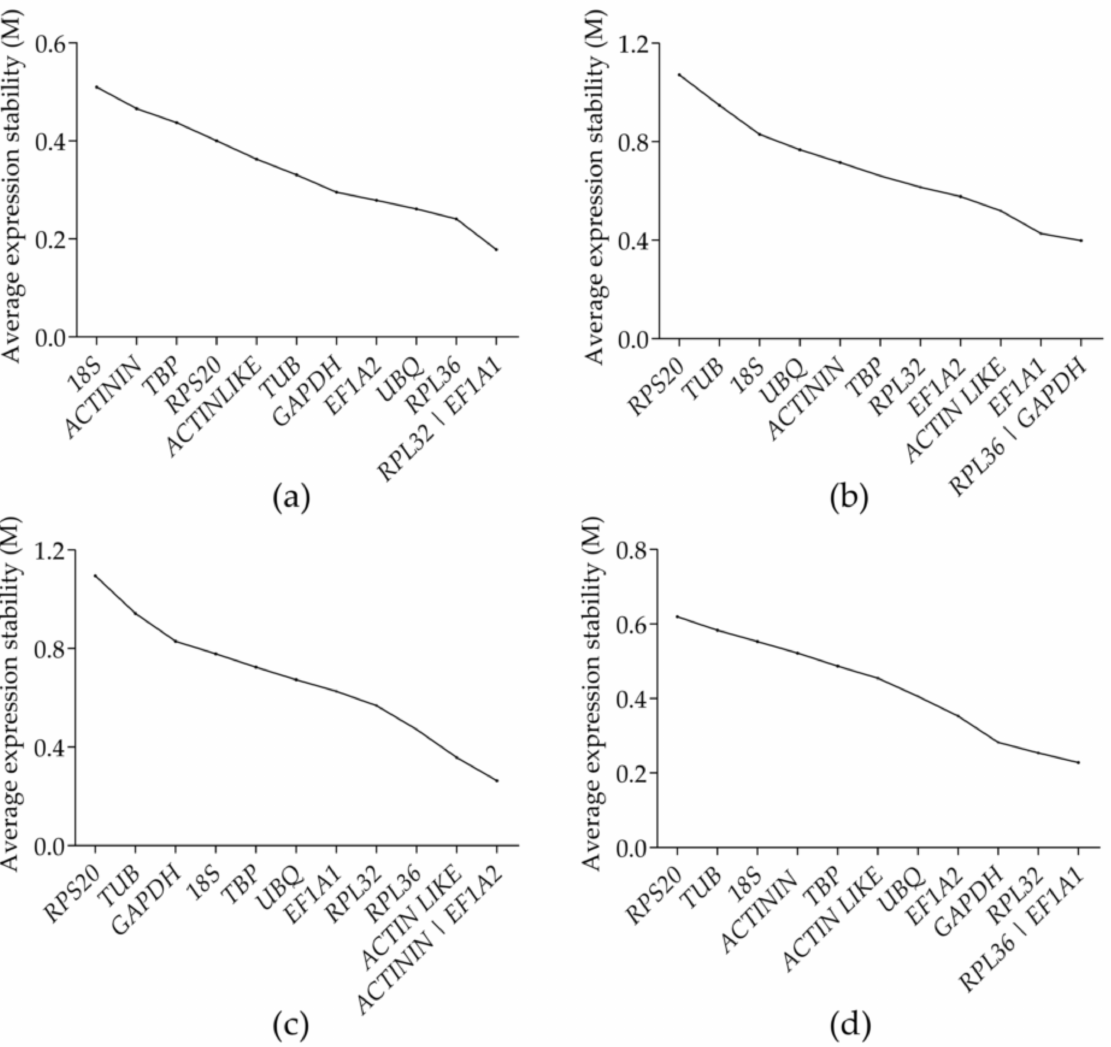
Figure 2. Stability of expression of the candidate reference genes in Glenea cantor , as calculated by geNorm: ( a ) adult tissues; ( b ) developmental stages; ( c ) sexes; and ( d ) all